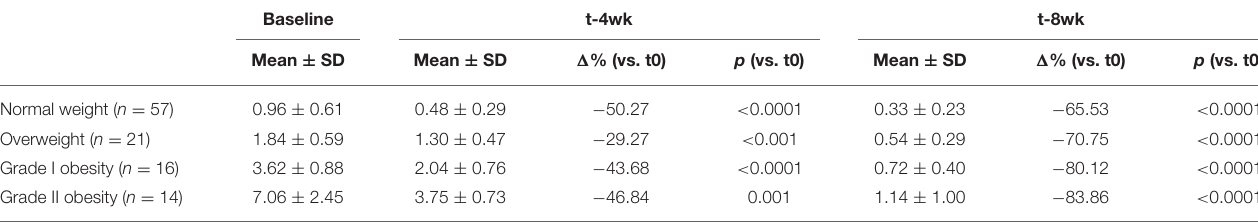
TABLE 4 | Serum levels of TMAO before and after 4-week and 8-week treatment with Taurisolo ® in study participants stratified for BMI. Baseline